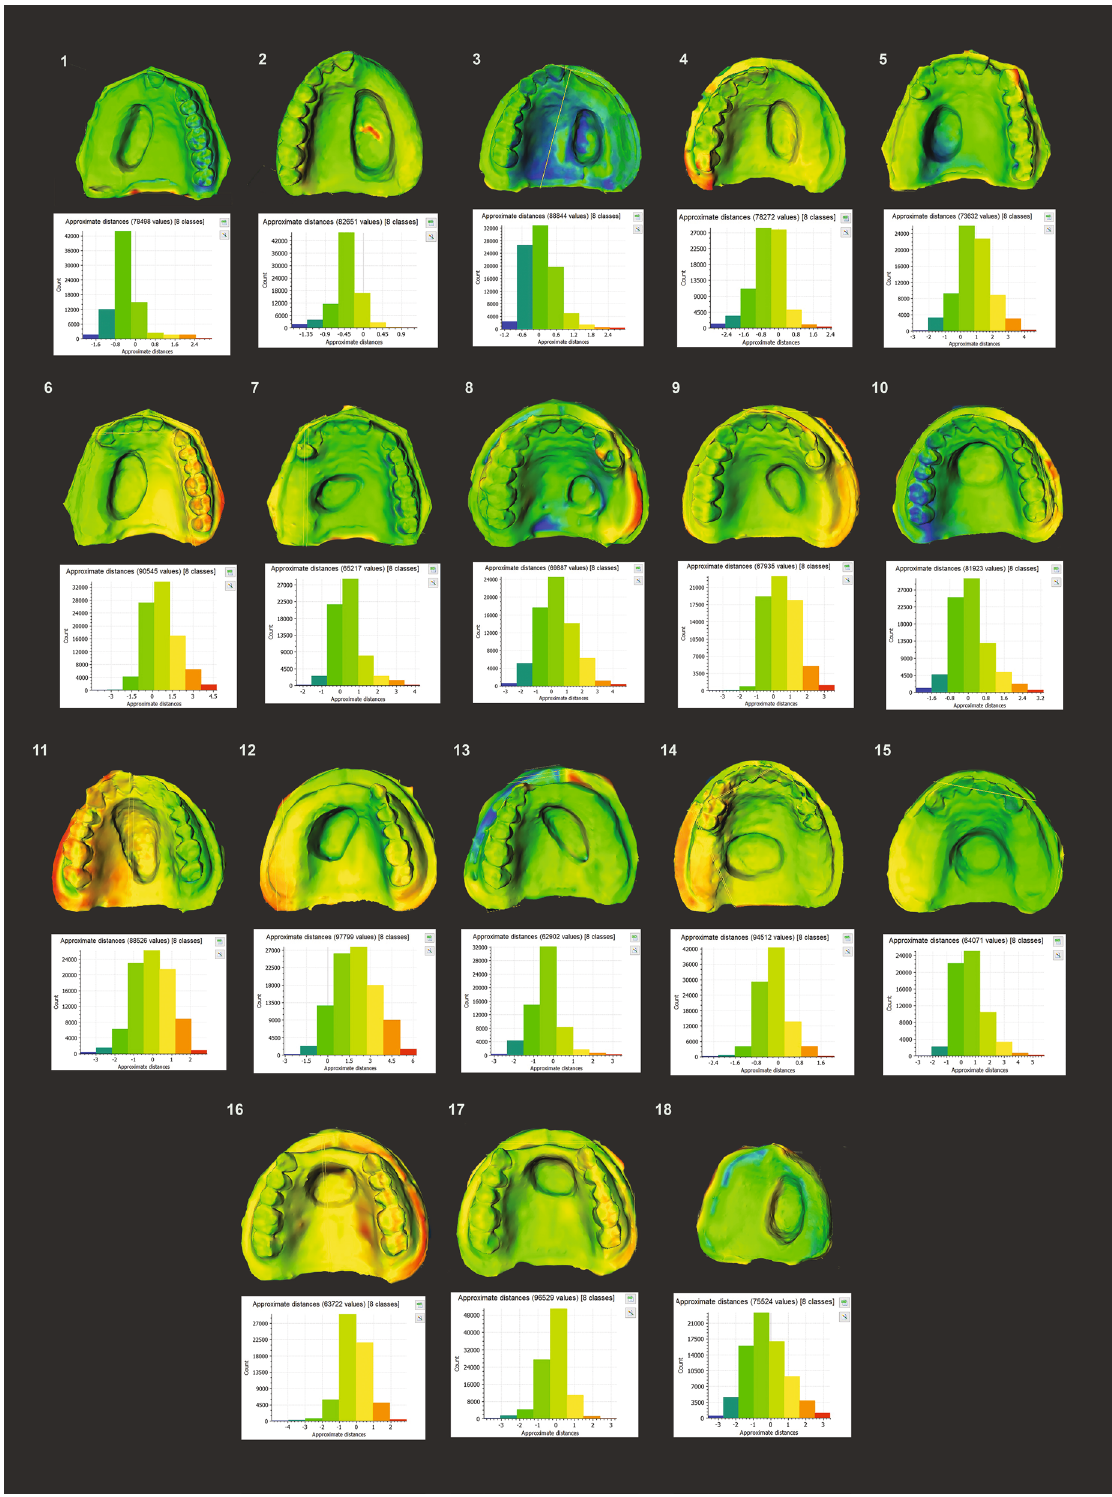
Figure 4. Area discordance reports for Phase C. The amount of HD variation per model comparison is shown in the bar chart and is colour coded. The exact location of the discrepancy is shown on the model above with the respective